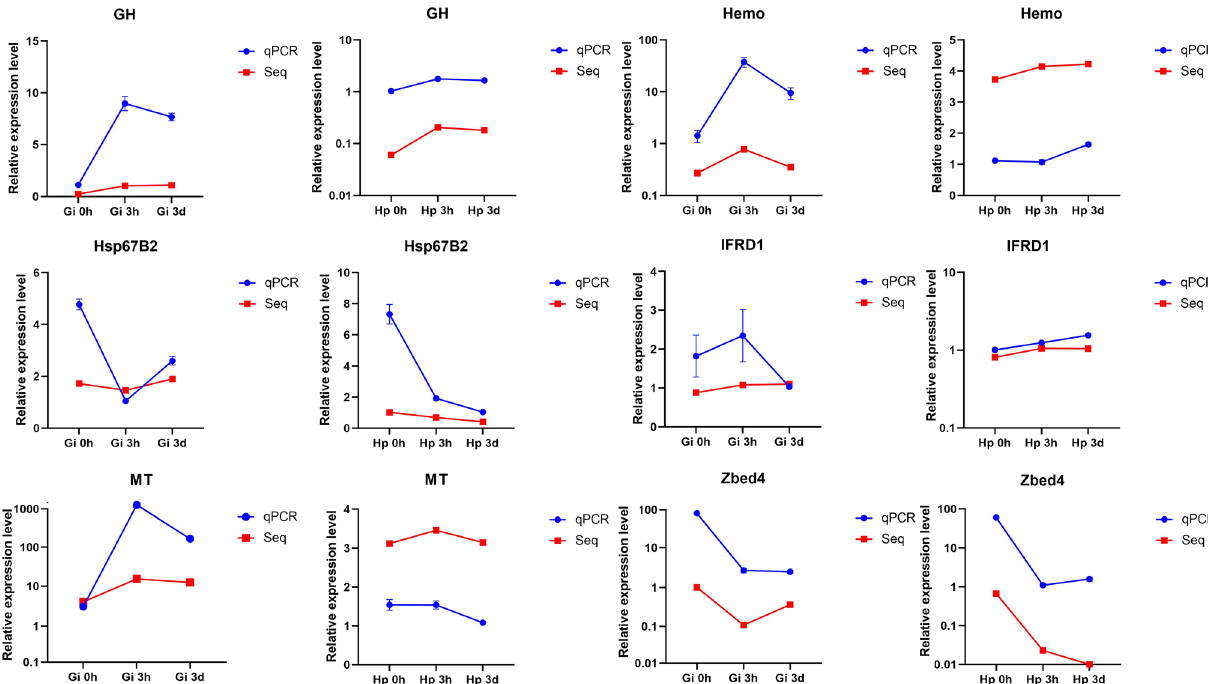
Figure 7. Validation of the relative expression level of six genes associated with Cd 2+ stress using quantitative real time PCR. Blue bar represents the qPCR results, and red bar represents the RNA-Seq results. MT metallothionein, Hemo hemocyanin-like protein, IFRD1 interferon-related developmental regulator 1, Hsp67B2 heat shock protein 67B2-like, Zbed4 zinc finger BED domain-containing protein 4-like, GH gamma-glutamyl